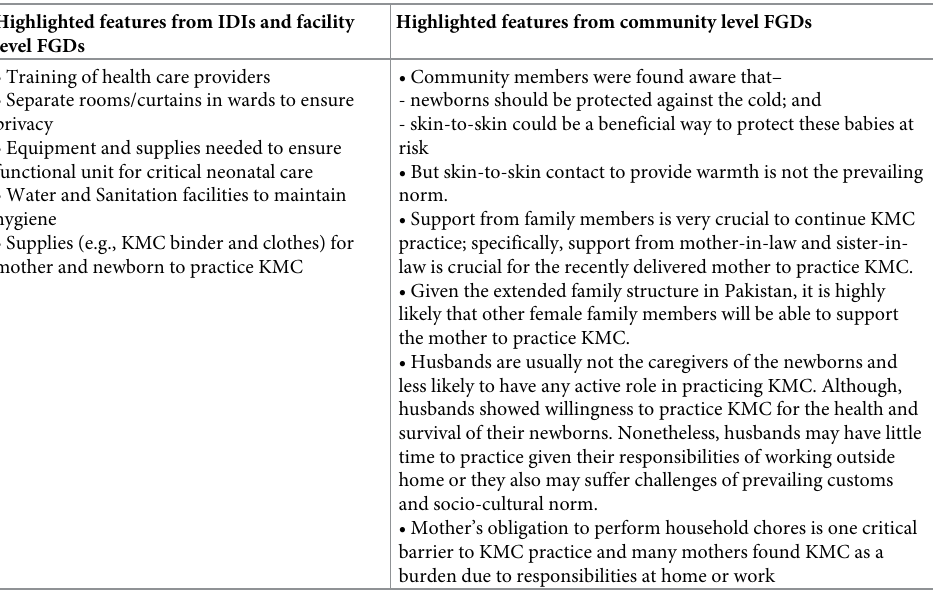
Table 3. Summarized results from respondents at health facilities and community. Highlighted features from IDIs and facility level